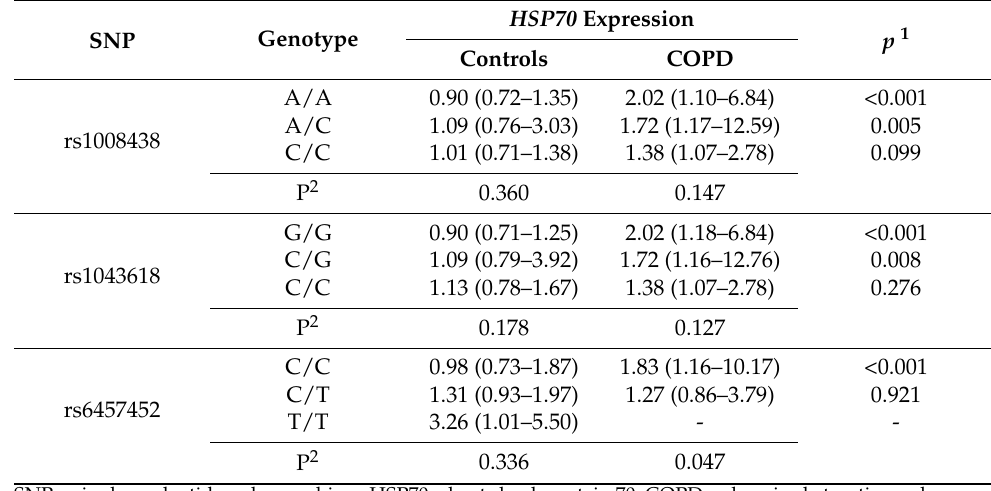
Table 7. Association of HSP70 polymorphisms with HSP70 expression.